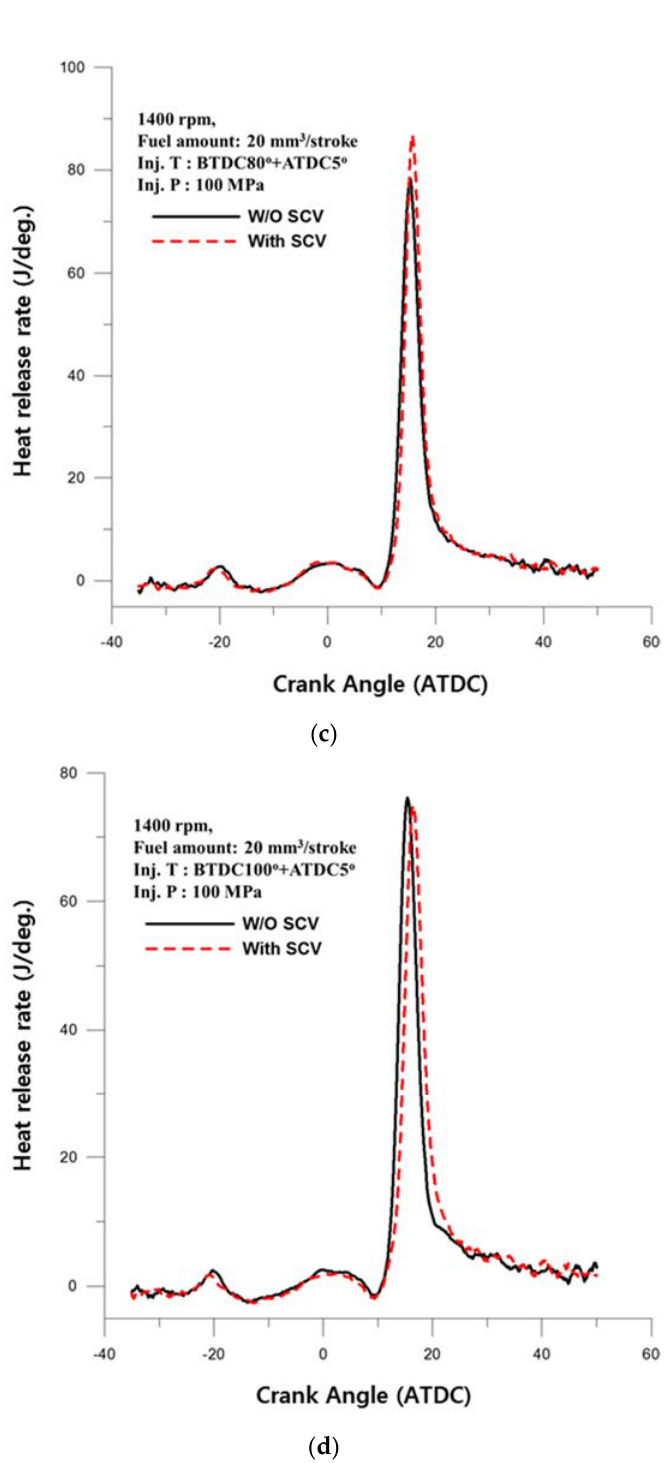
Figure 8. The effect on the SCV of the heat release rate during the 2nd injection (1400 rpm, injection amount: 20 mm 3 /stroke, 2nd injection timing: ATDC 5°). ( a ) Injection timing, 1st injection: BTDC 50°, 2nd injection: ATDC 5°; ( b ) Injection timing, 1st injection: BTDC 60°, 2nd injection: ATDC 5°; ( c ) Injection timing, 1st injection: BTDC 80°, 2nd injection: ATDC 5°; ( d ) Injection timing, 1st injection: BTDC 100°, 2nd injection: ATDC 5°.